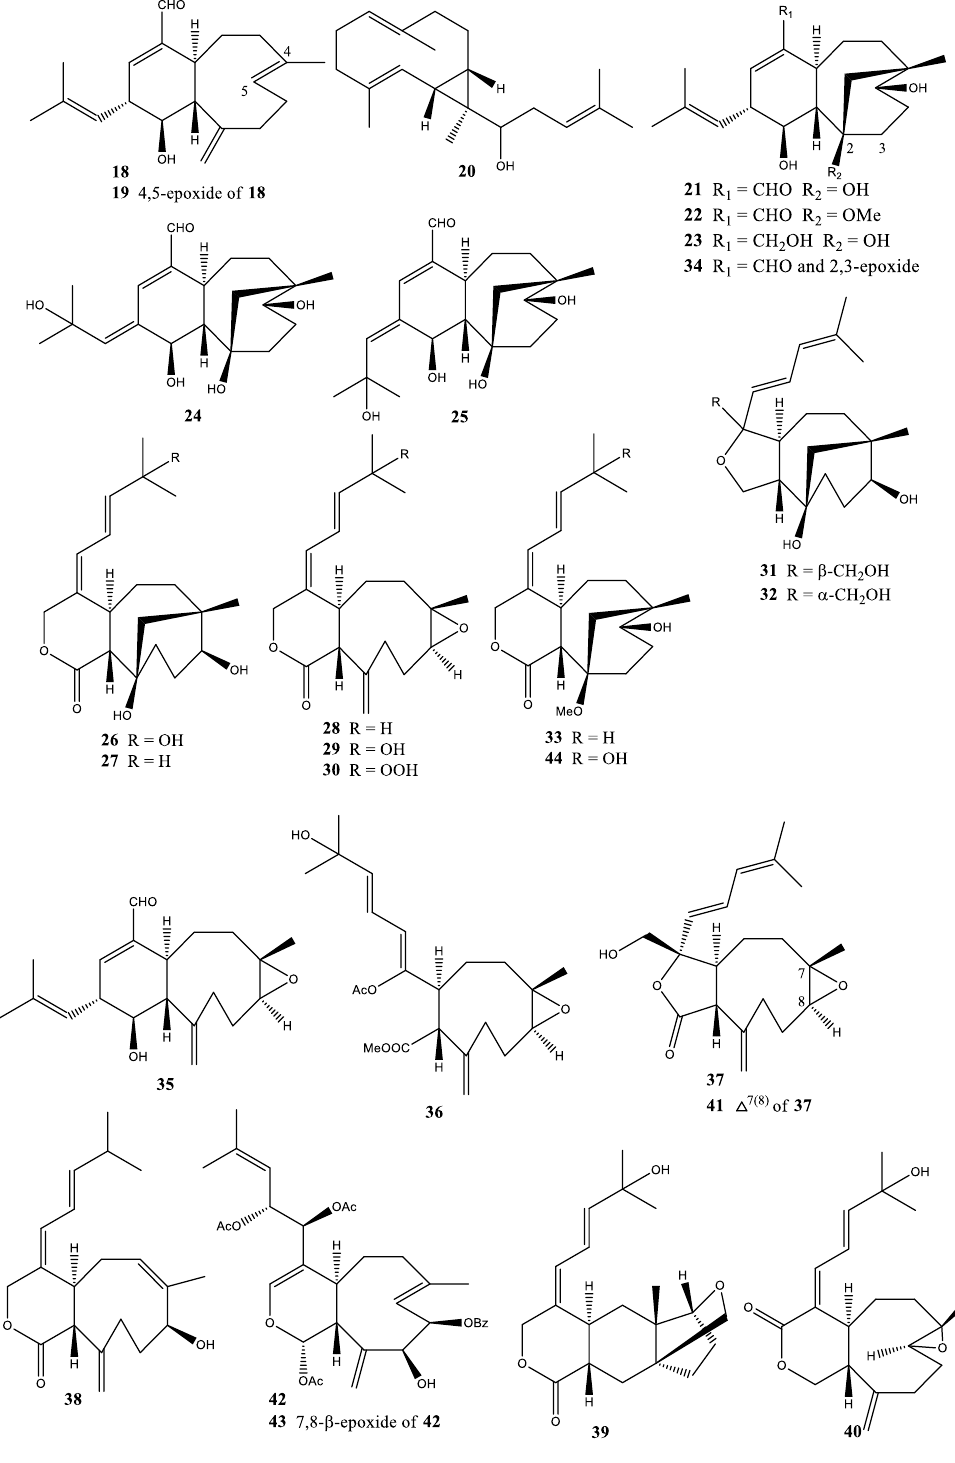
Figure 3. Structures of compounds 18 – 44 .